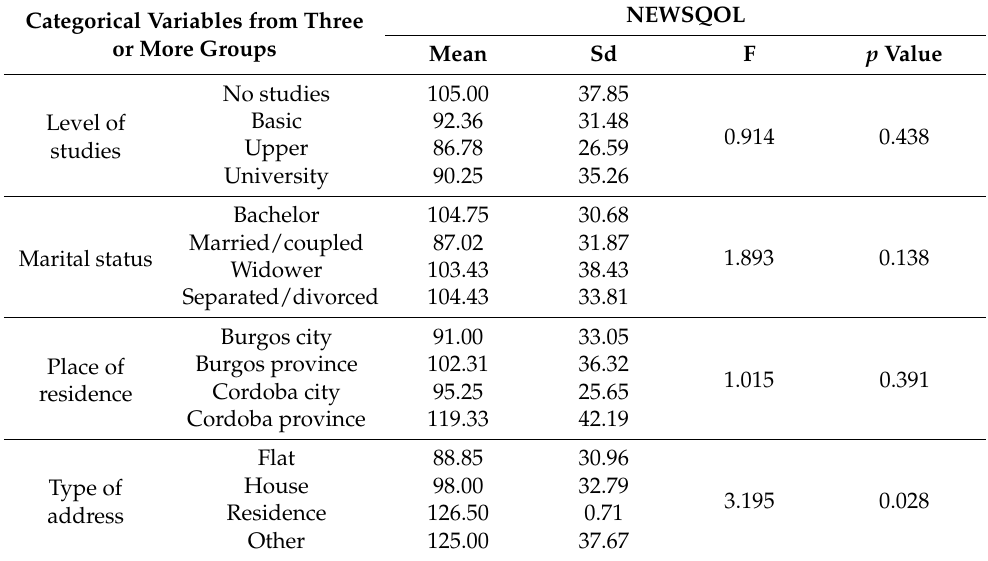
Table 6. Differences between independent study variables of three or more groups in quality of life using ANOVA.